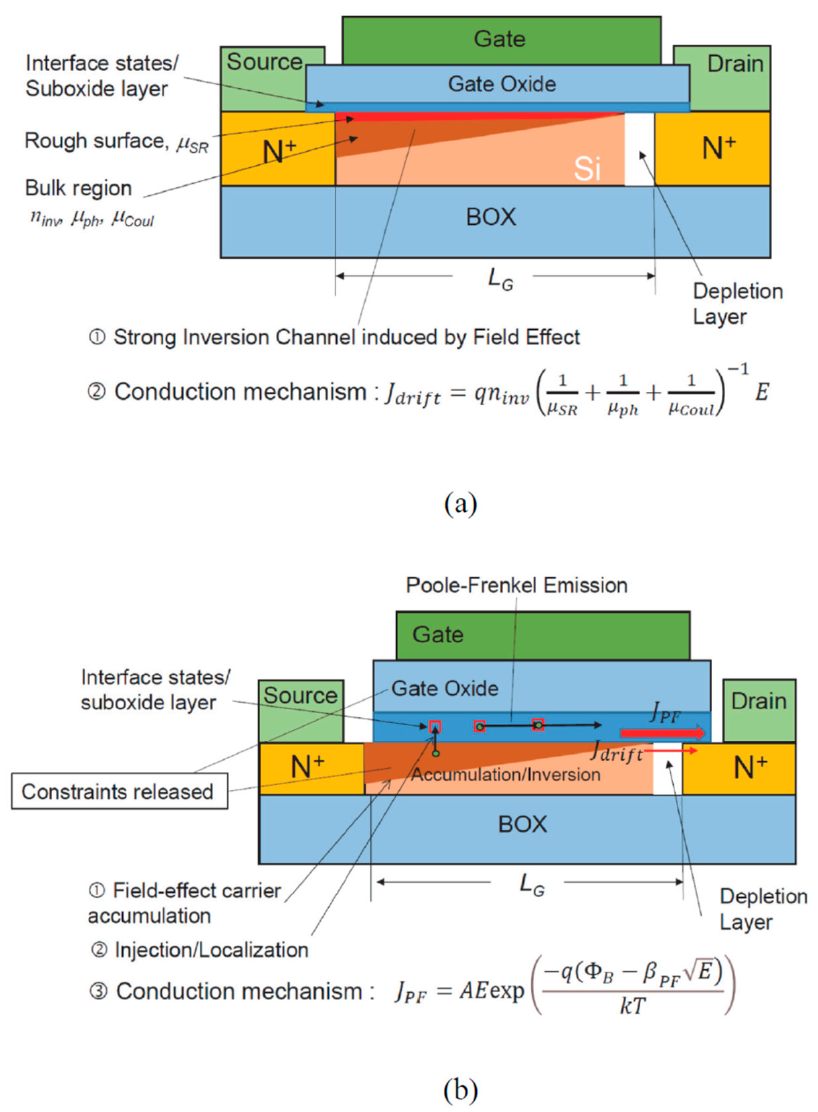
Figure 6. Structural and operation mechanism comparison between the MOSFET ( a ) and the proposed PF-MOS ( b ).